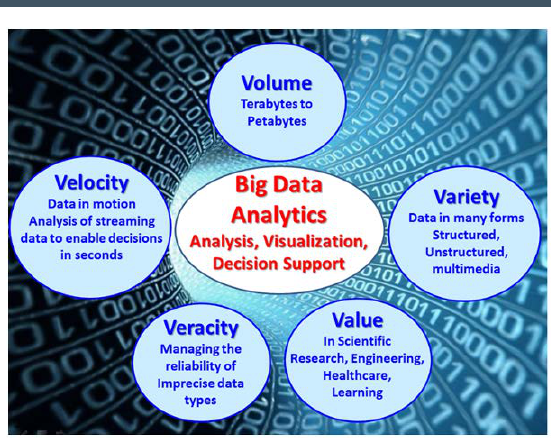
Figure 3. The 5 Vs of Big Data